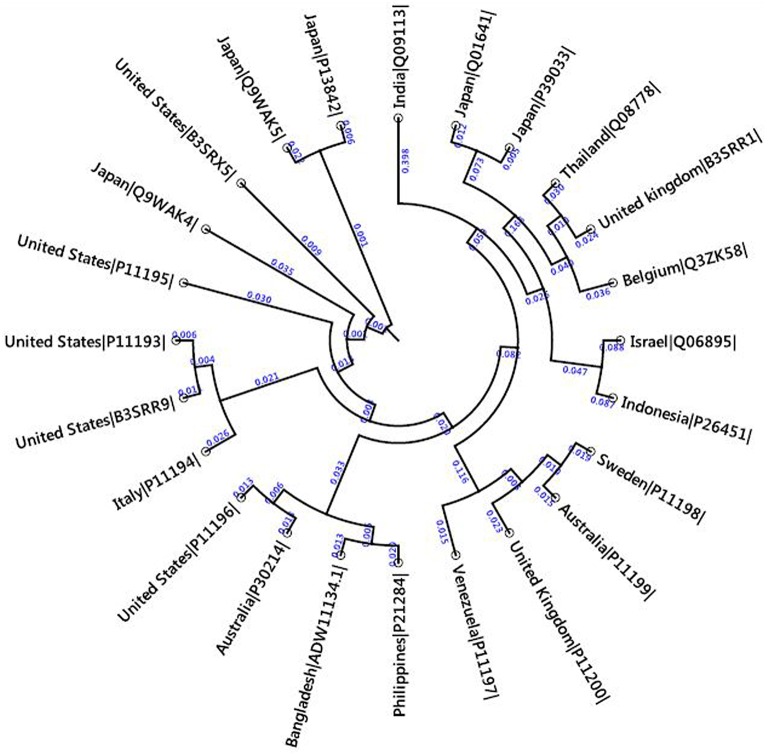
Divergence analysis of 24 VP4 proteins from 14 different countries. The neighbor joining method was used for phylogenetic tree construction for iteratively joining clusters which are close to each other but at the same time far from all other clusters. In this method, “Kimura” protein distance measurement was selected for the equal amino acid frequency and equal substitution rates. Bootstrap value was also shown by producing 1000 replicates for measuring the accurate distance among the 24 strains.